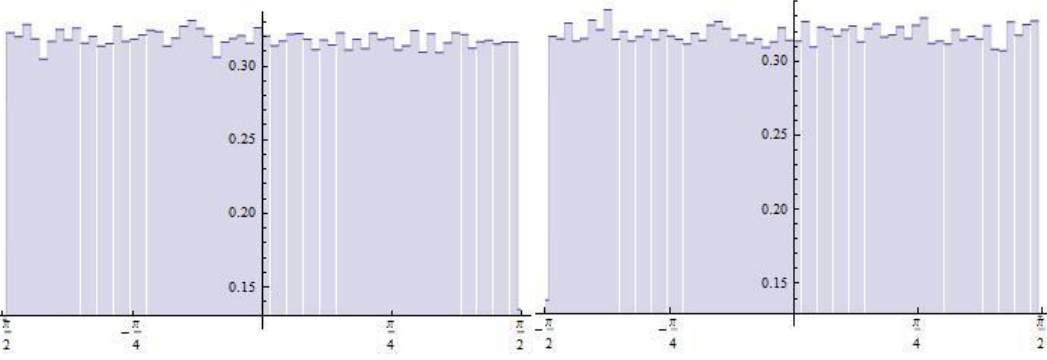
Figure 7. Cipher image histograms based on weighted data for the non-fractal image (Figure 1 on the right side): after encryption with the 2D QRT linear map in Eq. (28) (left) ) for 0 . 15   , and after encryption with the 2D mKdV linear map in Eq. (29)